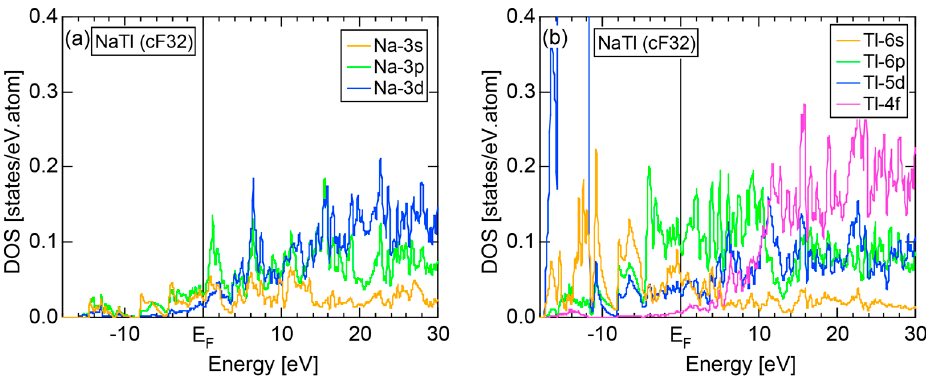
Figure 60. ( a ) Na- and ( b ) Tl-pDOSs for NaTl (cF32) [11,41]. Crystals 2017 , 7 , 9